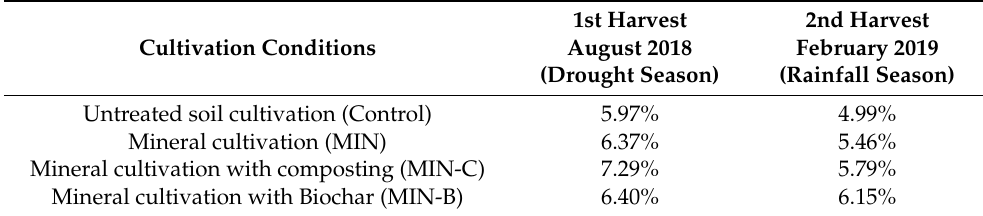
Table 3. The total yield of M. oleifera leaf extracts from different soil cultivation and different harvest seasons.